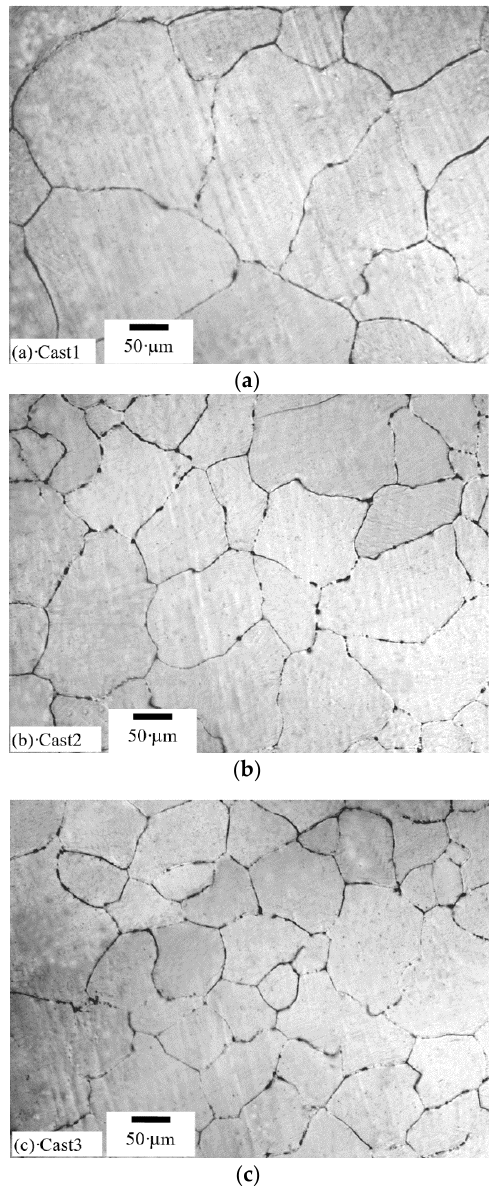
Figure 2. Light microscopy (LM) microstructure of the cast Mg alloys. ( a ) Cast1, ( b ) Cast2 and ( c ) Cast3.